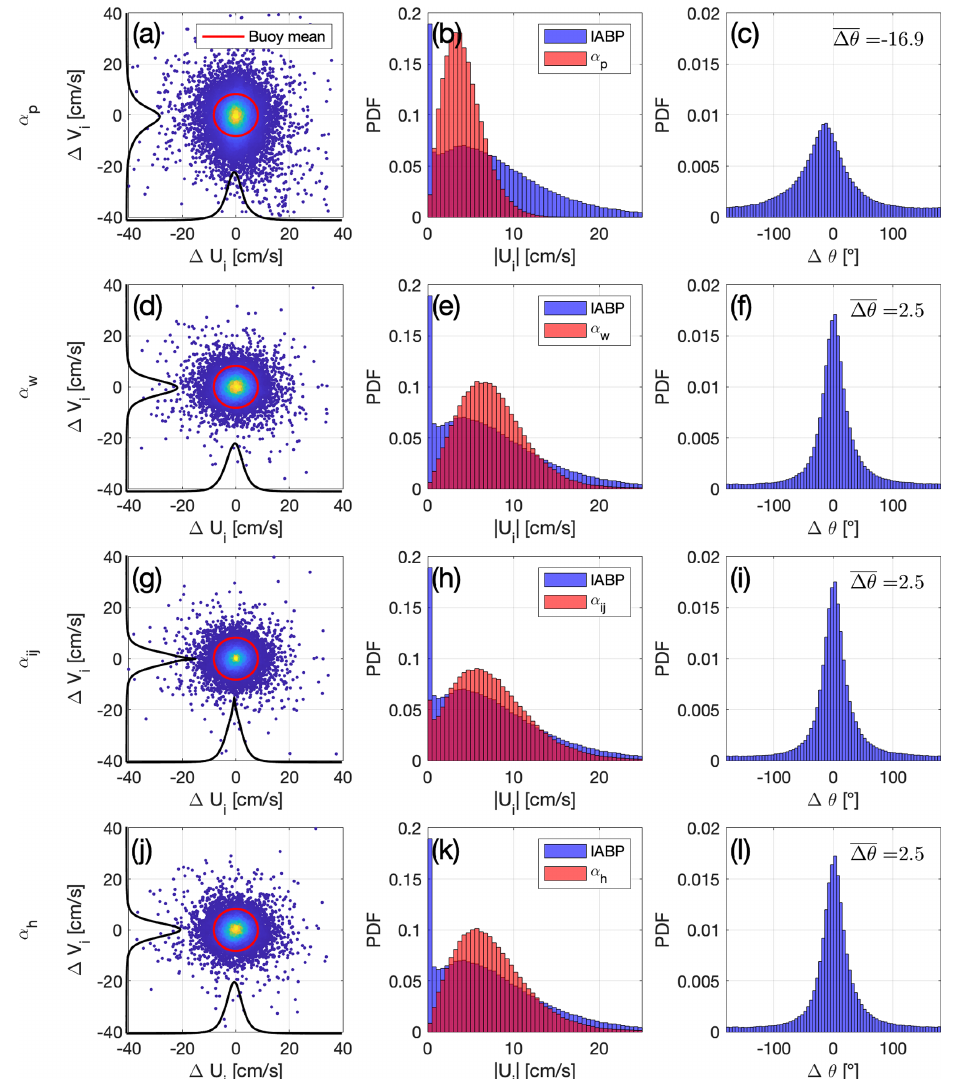
Figure 3. Error metrics for the α p Polar Pathfinder free-drift input (a–c) , constant α w free drift with ocean currents (d—f) , spatially varying transfer coefficient and turning angle (g–i) , and α h thickness-dependent free-drift parameterization (j–l) , taking the IABP buoys as the reference. Left column (a,d,g,j) : scatter plots of the error on the u and v components of sea ice velocity, where the color scale indicates the density of points; the red circle has a radius equal to the mean buoy drift speed; and the black curves illustrates the distribution of the error in each direction. Middle column (b,e,h,k) : distribution of the sea ice drift speed for the buoy data (blue) and for each of the free-drift estimates (red). Right column (c,f,i,l) : distribution of the drift direction error. All available data over the 1979–2019 period are included.